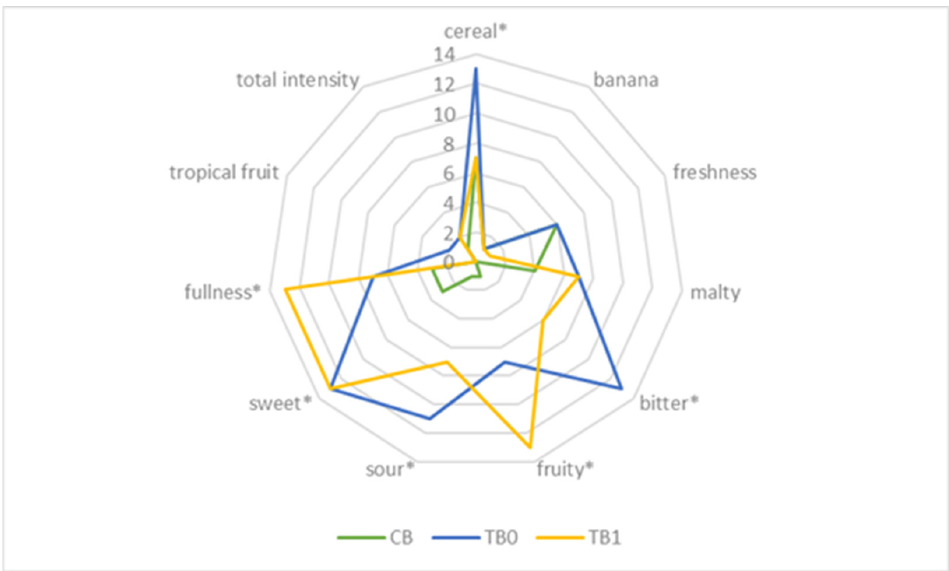
Figure 4. Sensory profile of wheat beers—control (CB) and sample with addition of the cv. ‘Thiessen’ fruit untreated (TB1) and treated with ozone (TB0) (* marks the attributes which were statistically different at p ≤ 0.05).